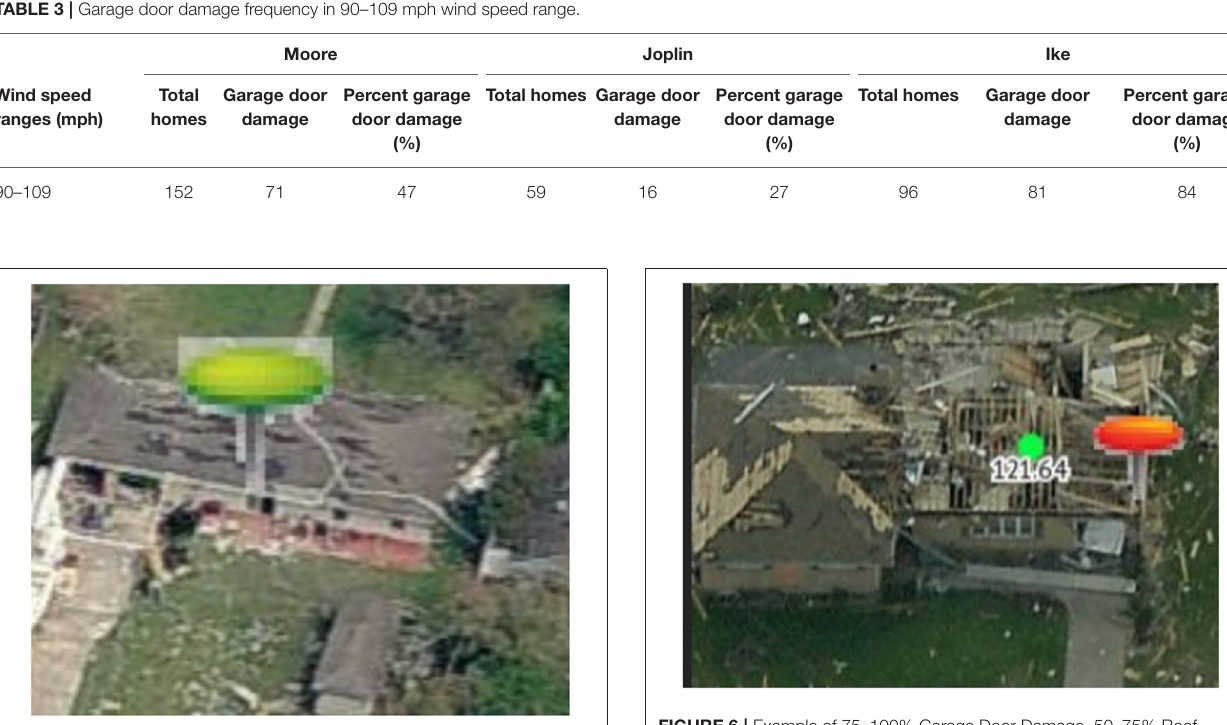
FIGURE 5 | Example of 75–100% Garage Door Damage, 0–25% Roof Structural Damage. Image resolution and quality reduced for publication. Image courtesy of Eagleview Technologies, Inc.